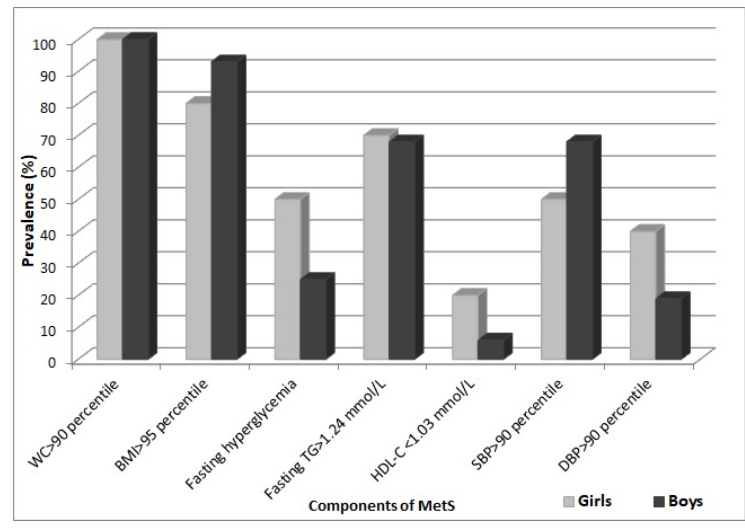
Figure 1. Percentage occurrence of components of MetS in girls and boys with MetS.